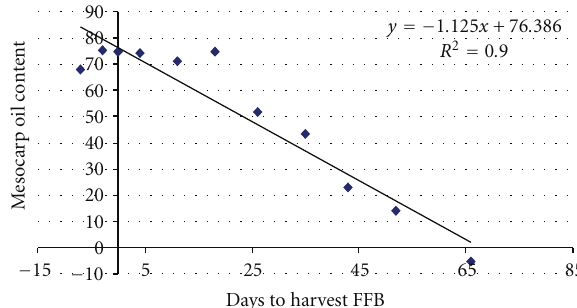
Figure 9: Estimation model of Mesocarp oil content for harvesting date